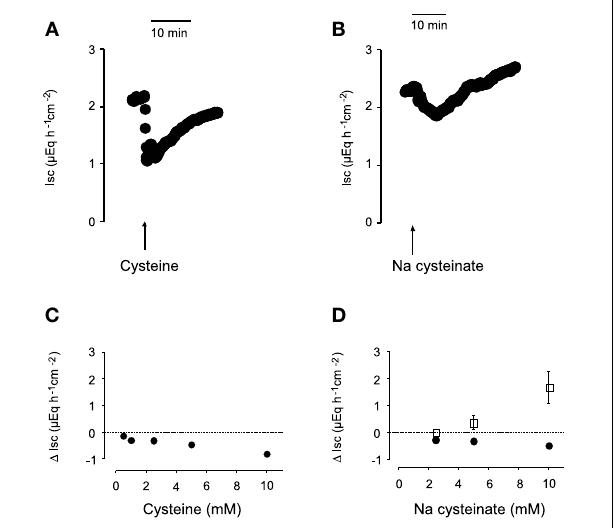
FIGURE 1 |Time course of the monophasic Isc response to free cysteine [(A), 10 − 2 mol · l − 1 at the serosal side; indicated by the arrow] and of the biphasic response evoked by Na cysteinate [(B), 10 − 2 mol · l − 1 at the serosal side; indicated by the arrow]. ( C,D) Concentration- dependent initial decrease (filled circles) and secondary increase (filled squares) in Isc induced by serosal administration of free cysteine (C) or Na cysteinate (D) in mucosa–submucosa preparations of rat distal colon.The data are given as change of Isc ( Δ Isc) compared to baseline (indicated by the dashed line) just prior administration of the amino acid. Each administration of the amino acid in (C,D) was followed by three times washing the serosal compartment with fresh, cysteine-free buffer solution. Values are given as means (symbols) ± SEM (bars), n = 8.The decrease in Isc was statistically significant ( P < 0.05, paired t -test) for all concentrations of free cysteine or Na cysteinate tested, whereas the increase in Isc evoked by Na cysteinate reached statistical significance only for the highest concentration tested (10 − 2 mol · l − 1